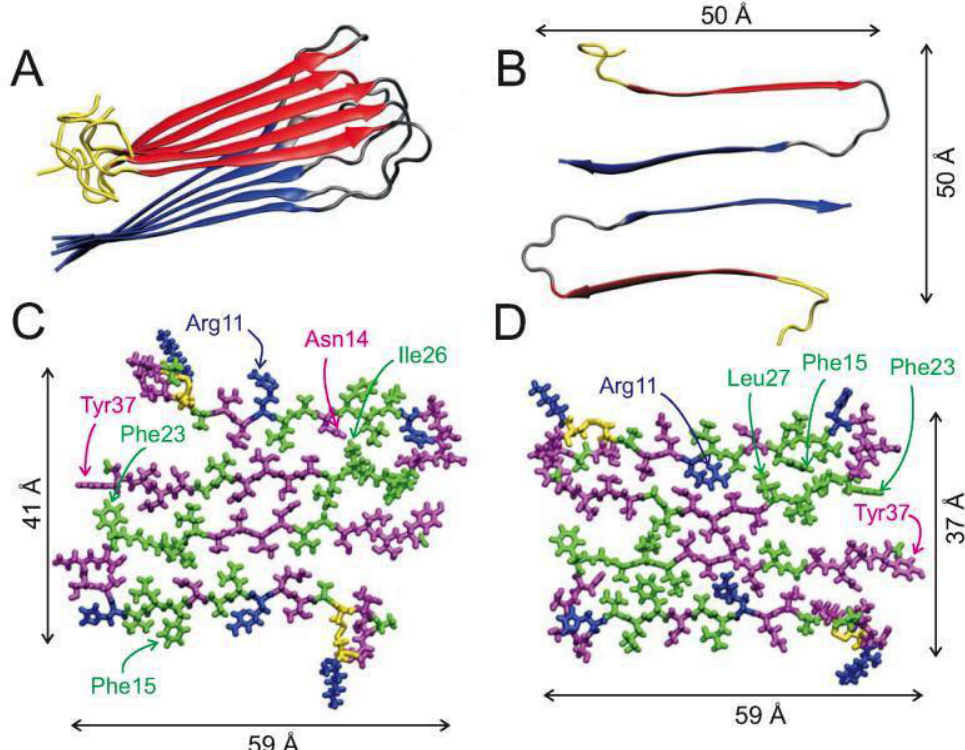
Figure 3. Structure of the fibrillary form of hIAPP: ( A ) Ribbon representation of the beta sheet conformation of hIAPP in fibrils determined by solid-state nuclear magnetic resonance (NMR) experiments; ( B ) Cross sectional view of two hIAPP monomers in the fibril form; ( C , D ) all atom representations of two possible models, with hydrophobic residues shown in green, polar in magenta, positively charged in blue, and the disulfide bond shown in yellow. Adapted from Luca et al. [40]. Copyright (2007) American Chemical Society.